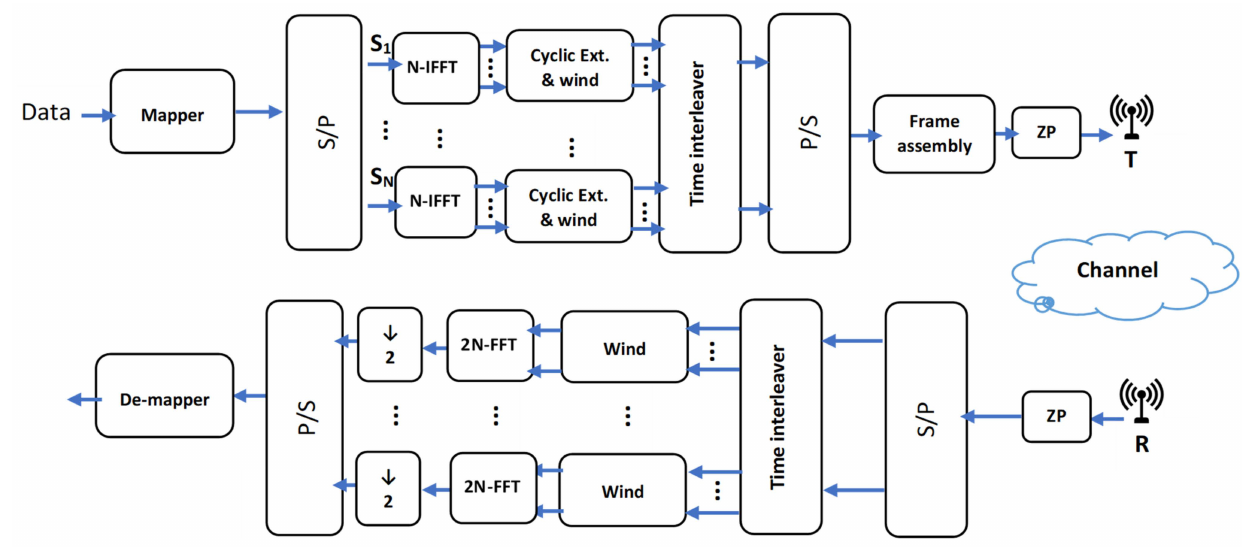
Figure 16. TIBWB-OFDM transceiver.